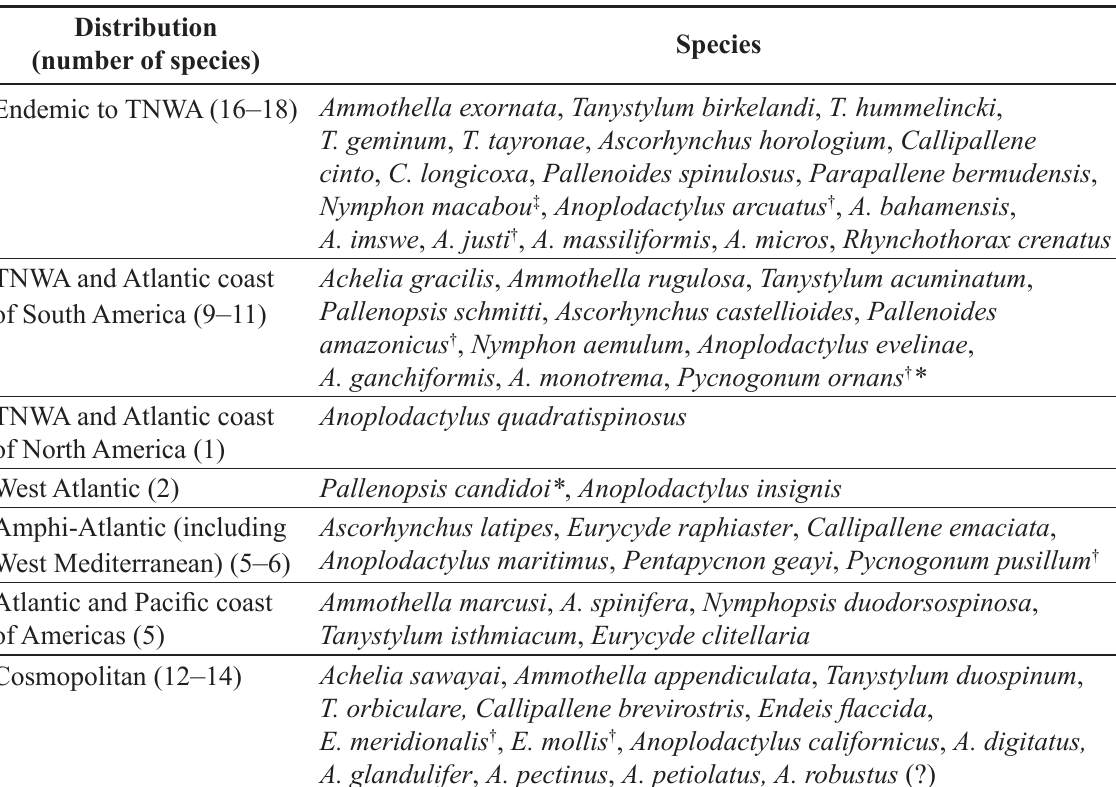
Table 3. Distribution of species known from Martinique in the world, present records included (new species in this study excluded). * species recorded for the first time in the TNWA. † species not formally identified in Martinique ( cf ., aff ., etc.). ‡ only known from